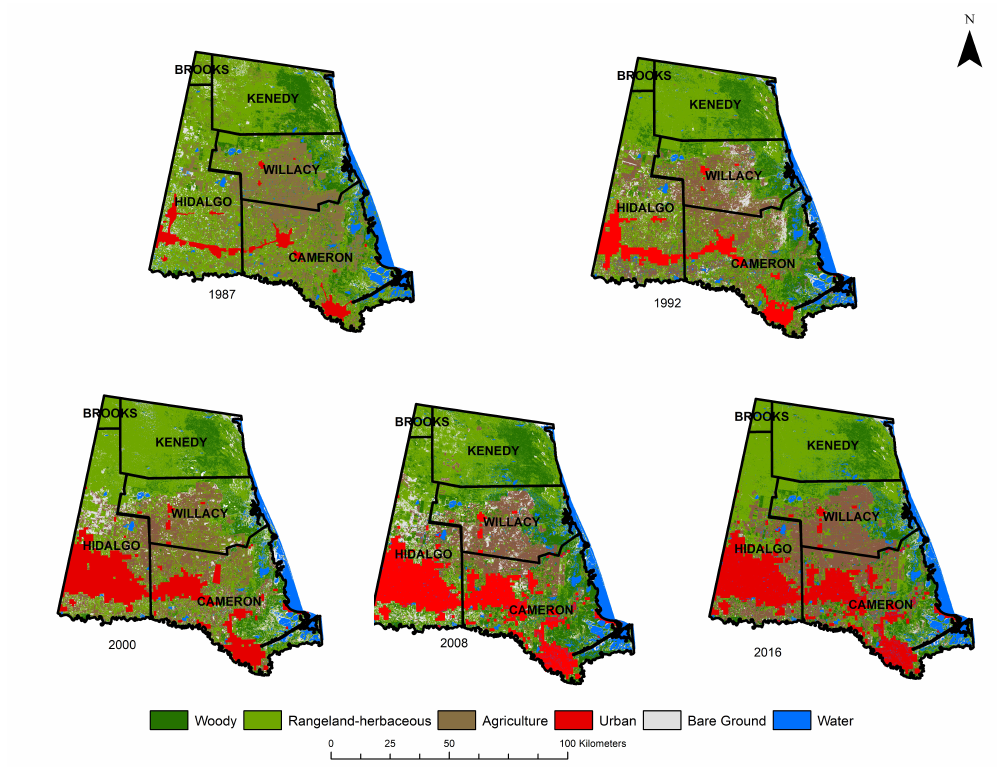
Figure 2. Comparison of 1987, 1992, 2000, 2008, and 2016 land cover (i.e., woody cover, rangeland-herbaceous cover, agriculture, urban areas, bare ground and water) in the Rio Grande Delta and surrounding rangeland study area (10,065 km 2 ) in South Texas, United States. Table 1. Comparison of means, standard error of mean (MSE), range, sample size (n), kurtosis, kurtosis standard error (KSE), skewness, and skewness standard error skewness (SSE) for patch size (PS; ha) and patch shape index (SI) of woody cover in the Rio Grande Delta and surrounding rangeland study area (10,065 km 2 ) in South Texas, United States in 1987, 1992, 2000, 2008, and 2016.